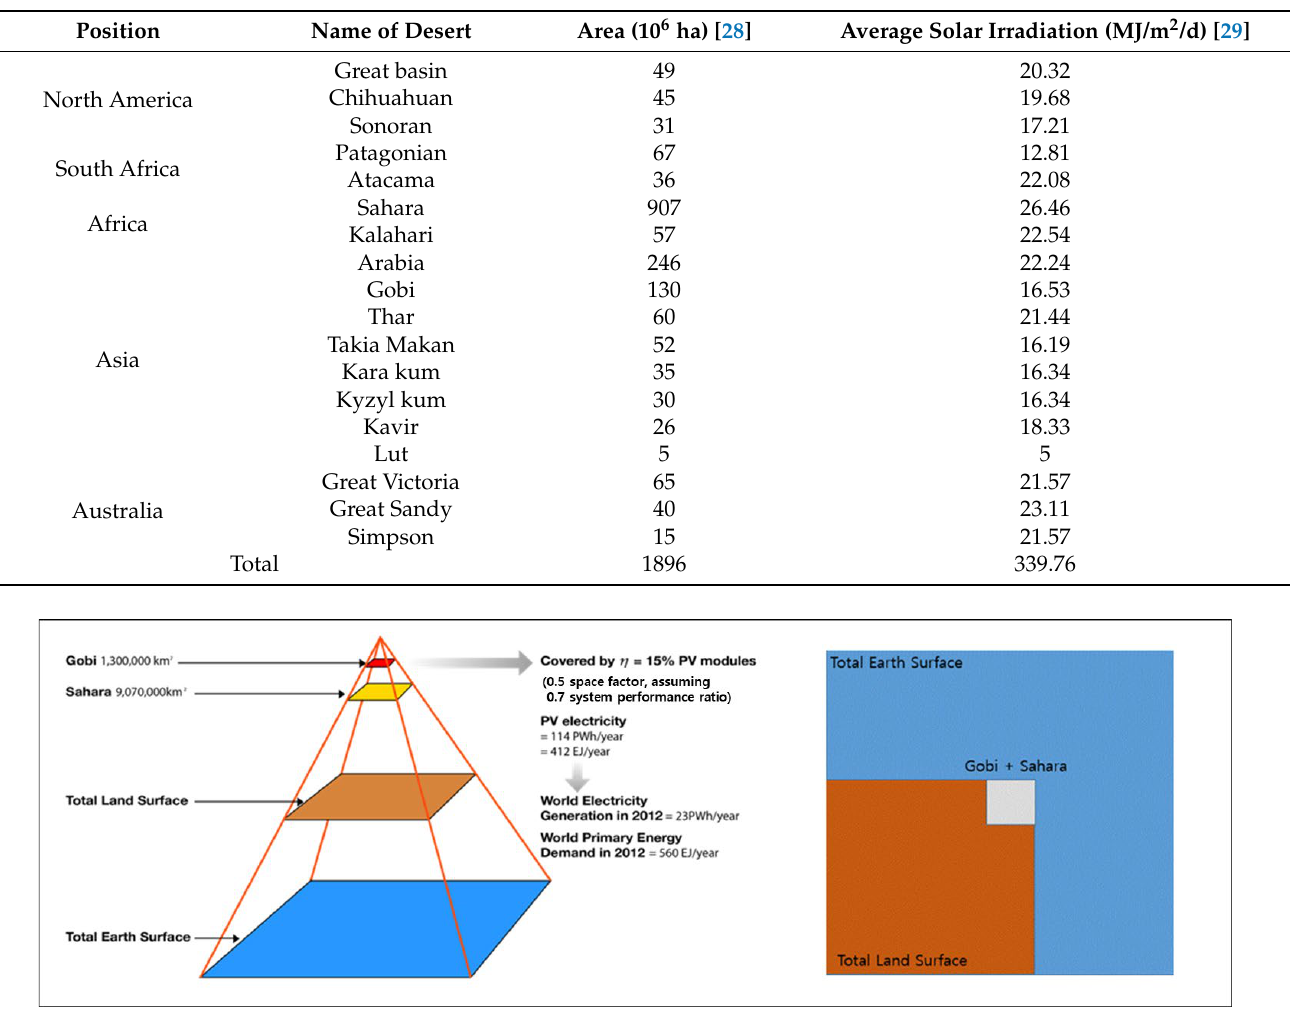
Table 1. The desert areas around the world.